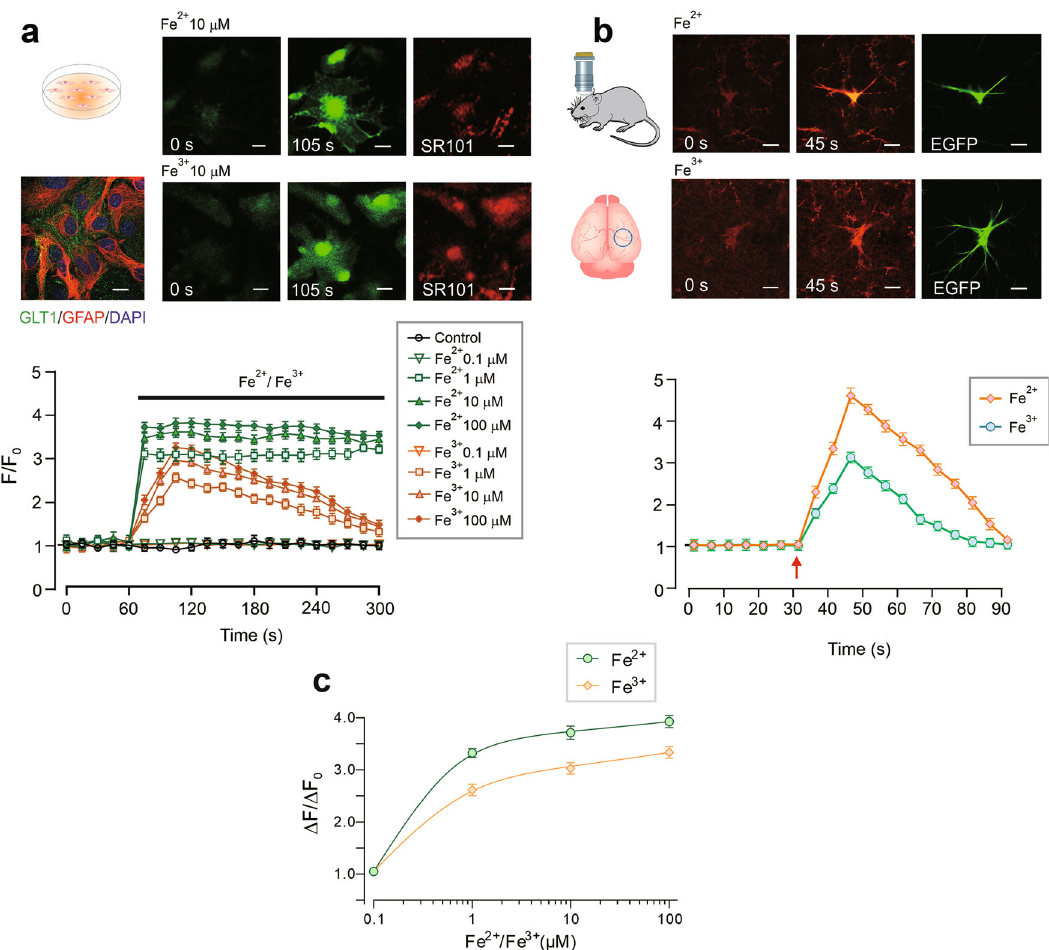
Fig. 1 Iron ions, Fe 2 + and Fe 3 + , evoke astrocytic intracellular Ca 2 + signals in vitro and in vivo. a Representative images (top panel) and intracellular Ca 2 + ([Ca 2 + ] i ) recordings from primary cultured astrocytes in response to different concentrations of Fe 2 + or Fe 3 + . Every data point represents mean ± SD, n = 10, p < 0.05, statistically signi fi cant difference from the value of baseline in the same group. The experiment was repeated in 10 different cultures. The representative image on the left shows the primary cultured astrocytes co-stained with GLT1 (green), GFAP (red), and DAPI (blue). Representative Fluo-4 images (green) show astrocytes treated by 10 μ M Fe 2 + or Fe 3 + at 0 s and 105 s of the recordings, the astrocytic identity was con fi rmed by co- staining with SR101. Scale bar, 20 μ m. b Images (top panel) and [Ca 2 + ] i recordings from cortical astrocytes in GFAP-eGFP transgenic mice using transcranial confocal microscopy. Every data point represents mean ± SD, n = 10 (different mice), p < 0.05, statistically signi fi cant difference from the value of baseline in the same group. Representative Rhod-2 images (red) show astrocytes treated with 100 μ M Fe 2 + or Fe 3 + at 0 s (baseline) and 45 s (peak of the response); GFAP-eGFP images (green) are shown on the right. Scale bar, 10 μ m. c Concentration-dependence of the maximal amplitude of [Ca 2 + ] i responses triggered by Fe 2 + or Fe 3 + in cultured